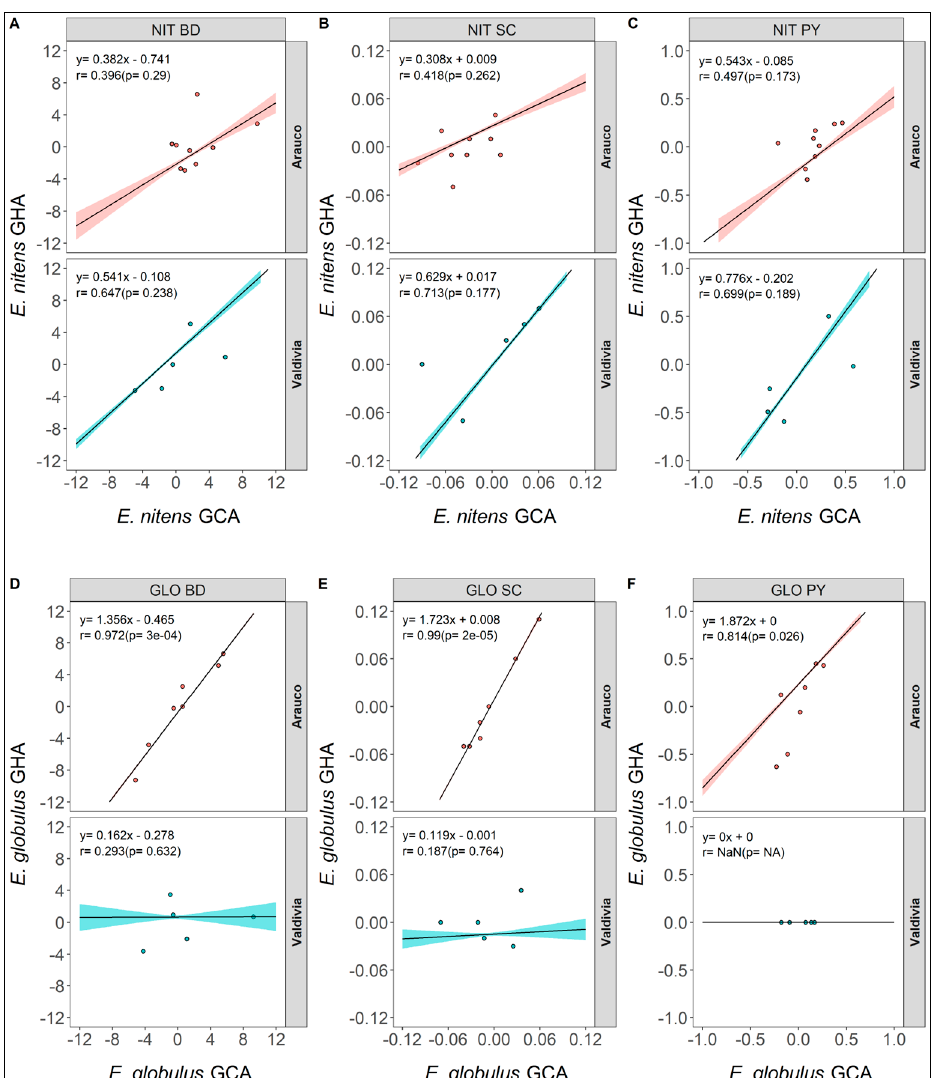
Figure 6. GHA vs. GCA on wood properties of E. nitens and E. globulus parents in Arauco and Valdivia breeding zones. In parenthesis, the p-value of each correlation per trait-species. (A) E. nitens GHA vs. GCA for Basic Density. (B) E. nitens GHA vs. GCA for Specific Consumption. (C) E. nitens GHA vs. GCA for Pulp Yield. (D) E. globulus GHA vs. GCA for Basic Density. (E) E. globulus GHA vs. GCA for Specific Consumption. (F) E. globulus GHA vs. GCA for Pulp Yield (The globulus PY relationship could not be plotted, since the globulus GHA variance of PY was zero in this zone).